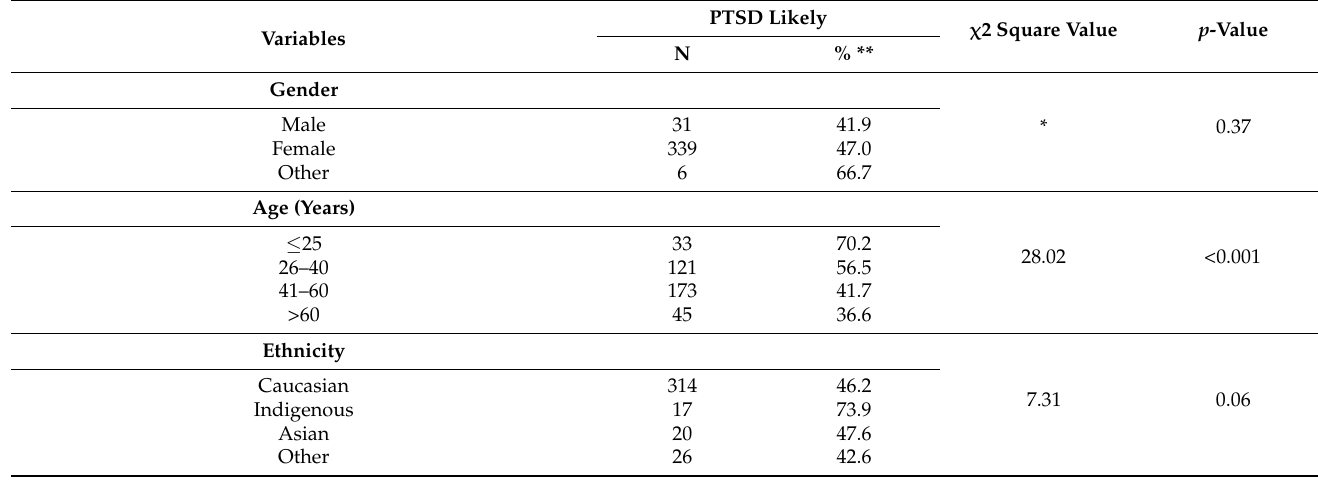
Table 3. Chi-Square test of association between the demographic and clinical antecedents and likely PTSD